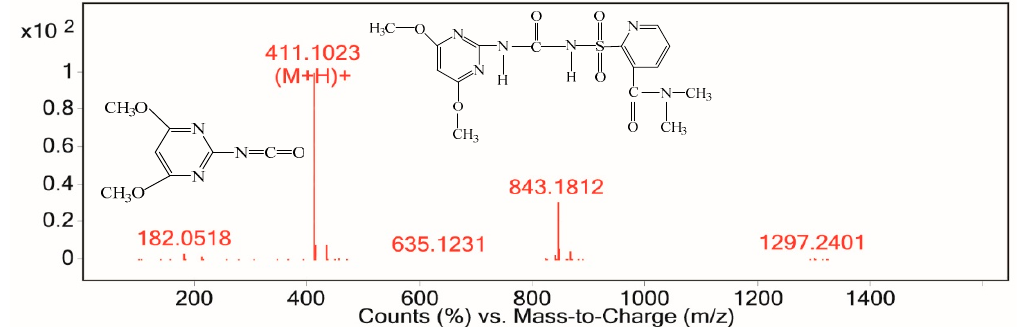
Figure 12. Electrospray ionization source (ESI) spectrum from 6.217 min to 6.367 min.